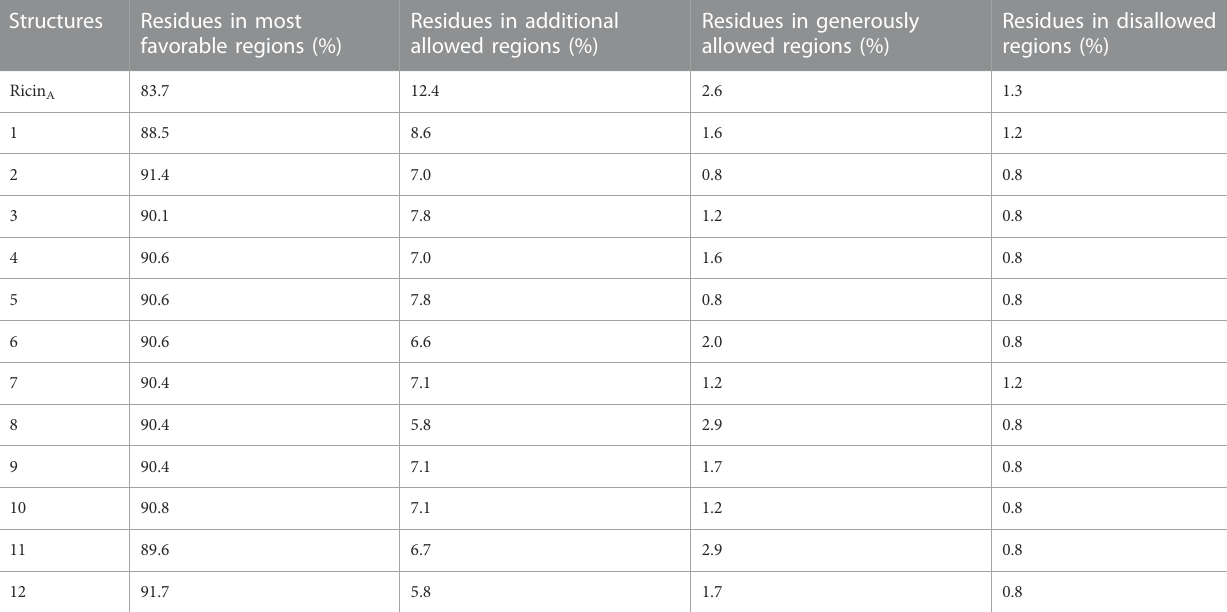
TABLE 2 Validation of the predicted chimeric proteins based on their Ramachandran plots. Structures Residues in most favorable regions (%)